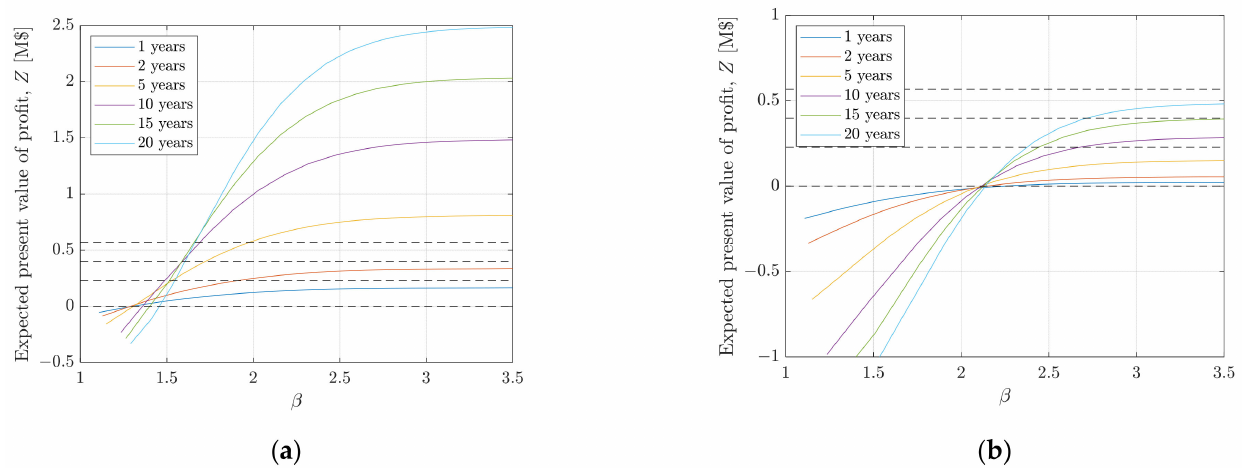
Figure 6. Expected present value of the profit Z as a function of the reliability index β in the last year of the extended life, for life extension periods: 1, 2, 5, 10, 15, and 20 years for: ( a ) PPA = 50; ( b ) PPA = 30. The dashed lines correspond to the costs of retrofits for (from the bottom): no repairs, low level, medium level, and high level.